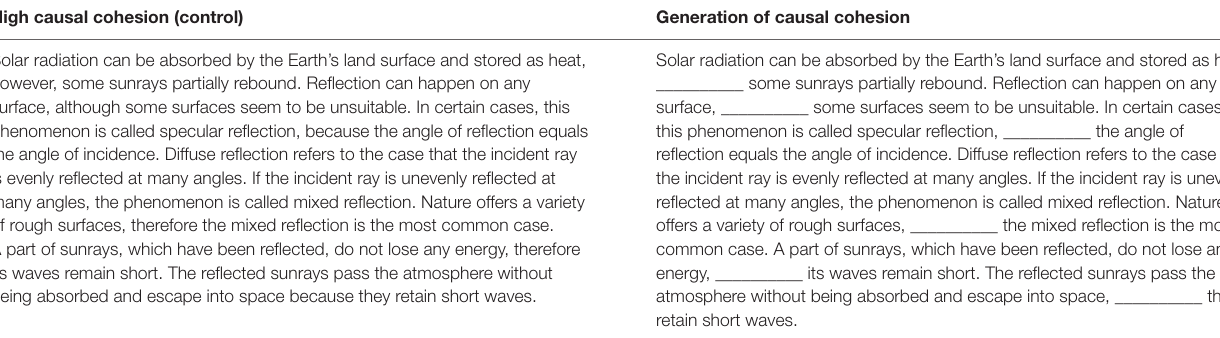
TABLE 1 | A sample text paragraph taken from the control and generation condition for